Question: What does this figure show? Answer in one sentence.
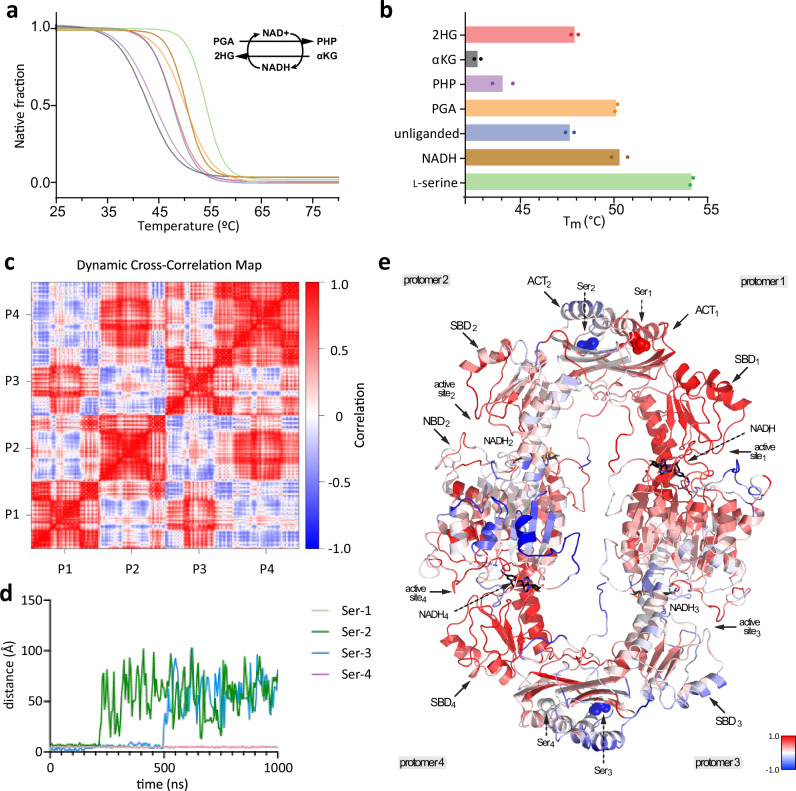
Answer: Serine-dependent modulation of inter-protomer communication. a Thermal unfolding transitions of Ser33 in the absence (blue) or presence of NADH (brown), PGA (orange), PHP (violet), 2HG (red), αKG (grey), or the negative allosteric regulator L-serine (green), monitored by changes in the CD signal at 222 nm. Raw data were corrected by buffer and blank subtraction, and subsequently normalized. The unfolding curves were fitted using a Boltzmann sigmoidal model in GraphPad Prism based on independent duplicates. b Histogram showing the mean apparent melting temperatures ( T M ) for each condition tested in ( a ). Dots represent T M values from two replicates ( n = 2). For each replicate, T M was determined as the midpoint of the fitted transition assuming a two-state equilibrium model. c Dynamic cross-correlation map (DCCM) derived from 200 ns molecular dynamics simulations of the serine-bound tetramer. The color scale (–1 to 1) reflects correlation coefficients between Cα atomic motions (red, positively correlated; blue, negatively correlated), revealing protomer-specific communication patterns. d Time evolution of the distance between the serine carboxylate oxygen and the His408 Nε2–H proton for each protomer. Ser-2 dissociates after ~200 ns, followed by Ser-3 at ~500 ns. Notably, these two serine residues occupy diagonally opposed positions within the tetramer, indicating an asymmetric and long-range regulatory effect. e Structural mapping of RMSF differences between the serine-bound and serine-free states of the tetrameric complex, obtained from 1 µs molecular dynamics simulations. The protein is represented as ribbons, displaying the four protomers (1–4) with their corresponding substrate-binding domains (SBD₁–SBD₄). The color scale represents normalized RMSF changes (red, increased flexibility; blue, decreased flexibility). Serine residues are shown as spheres, and the NAD ligands are depicted as sticks with carbon atoms colored in black. Serine binding globally red